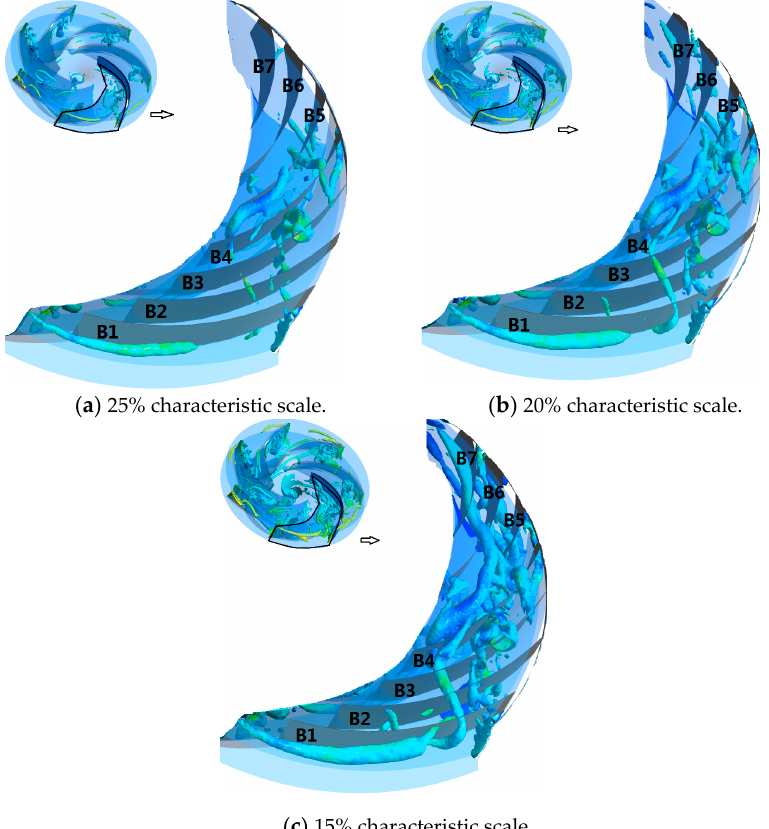
Figure 14. Vortex structures in one blade passage at 50%Pn.